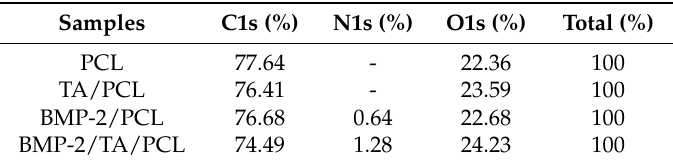
Table 1. Surface elemental compositions of PCL and modified PCL scaffolds determined by X-ray photoelectron spectroscopy